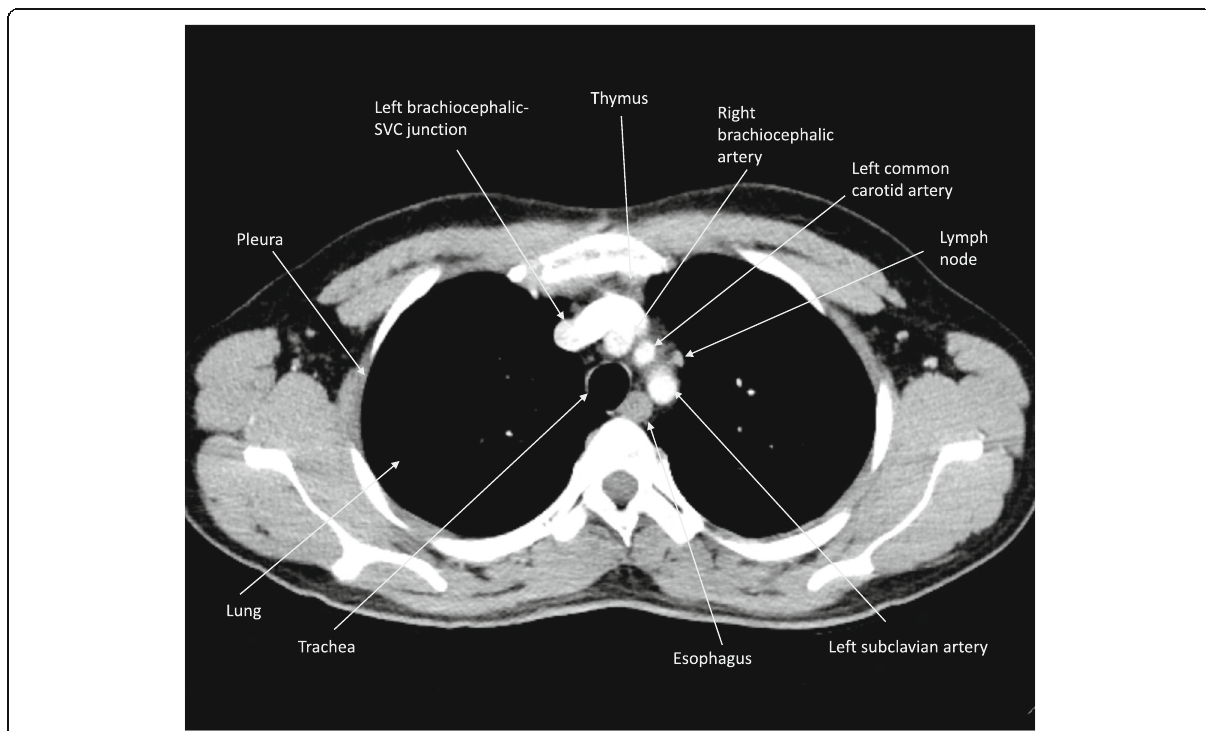
Fig. 3 Anatomical contents of the upper